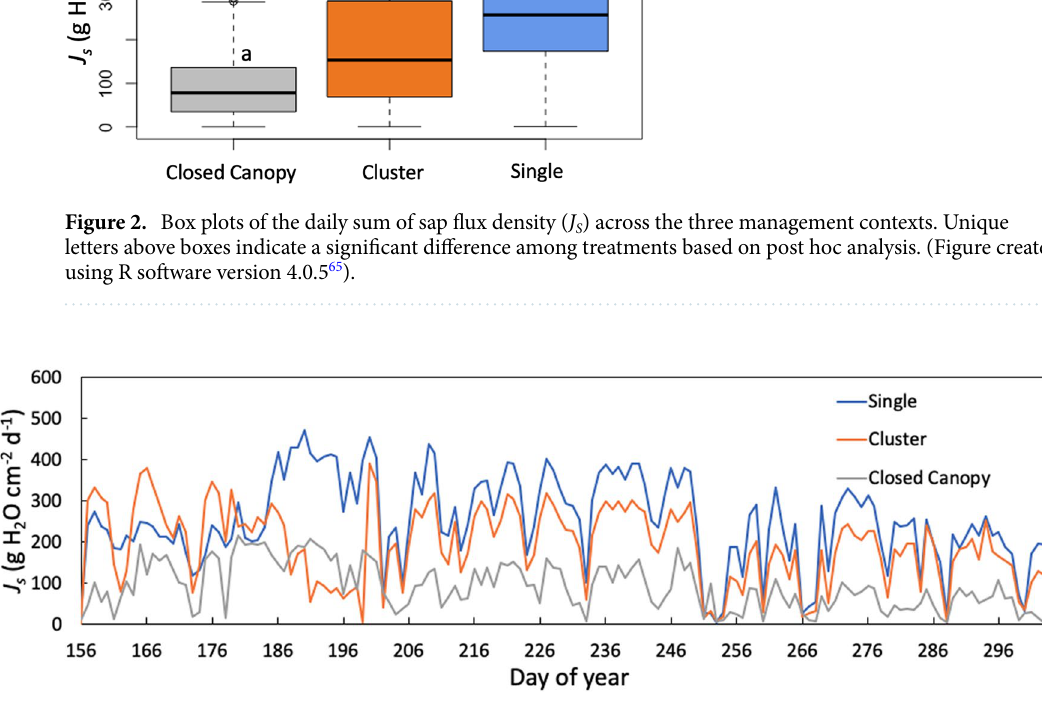
Figure 3. Time-series of the mean daily sum of sap flux density ( J S ) in the outer 2 cm measured in 2018 for the three management contexts.